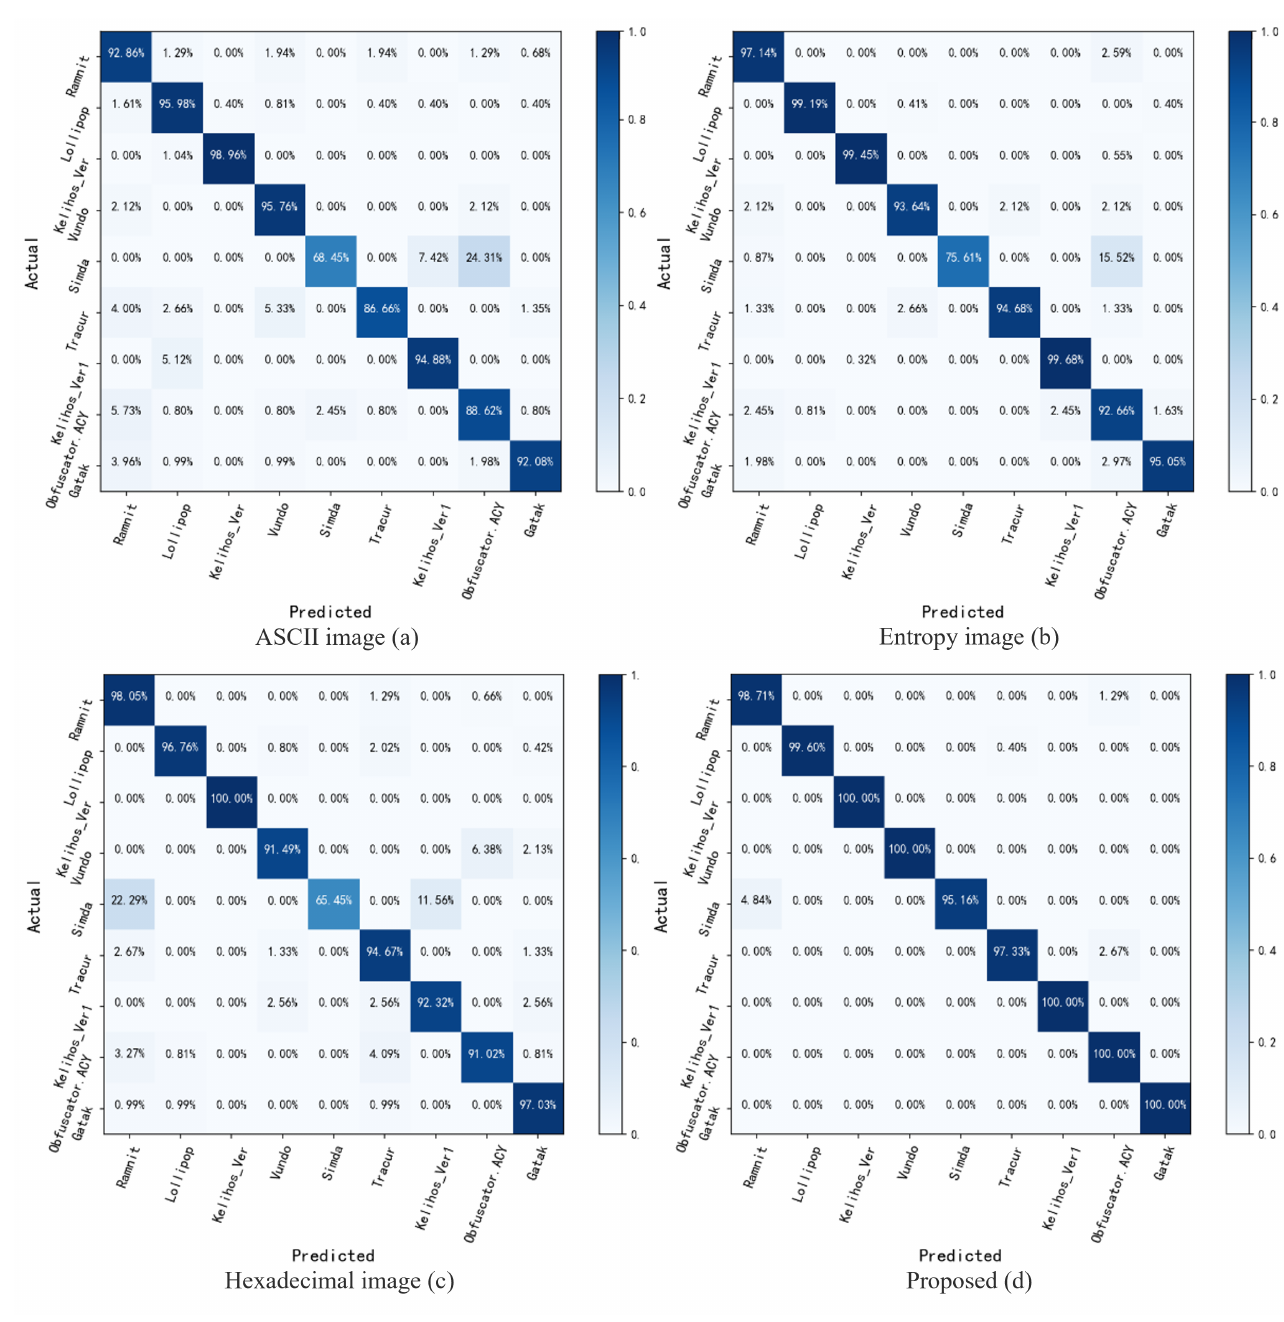
Figure 11. Confusion